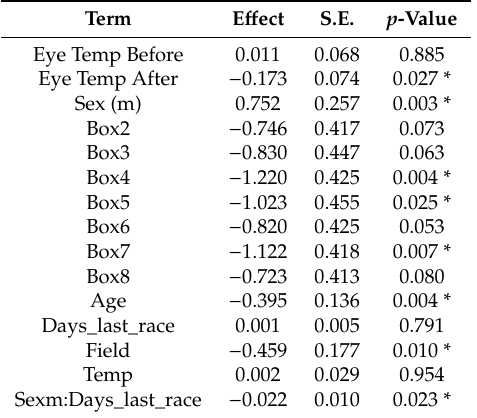
Table 4. Summary of an ordinal linear regression model on performance in racing